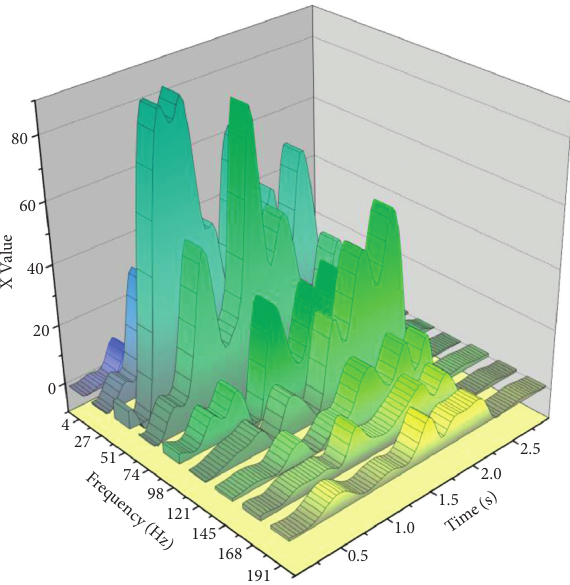
Figure 4: Interval information granulation of time